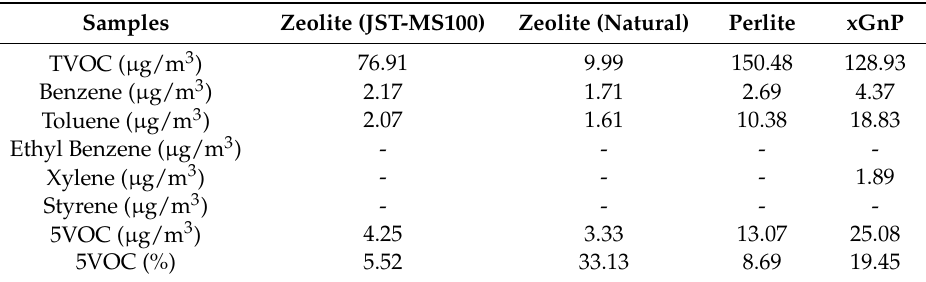
Table 2. Result of adsorption performance for seven days.